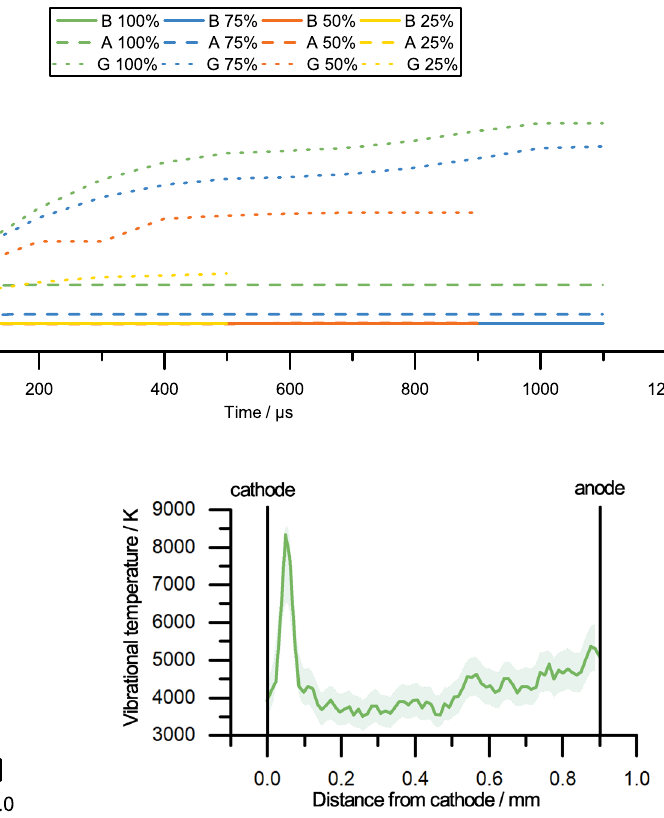
Fig. 6 Cumulative energy of the breakdown (’B’, solid line), arc discharge (’A’, dotted line) and glow discharge (’G’, dashed line) at an ignition coil dwell time of 100% (green), 75% (blue), 50% (orange) and 25% (yellow)